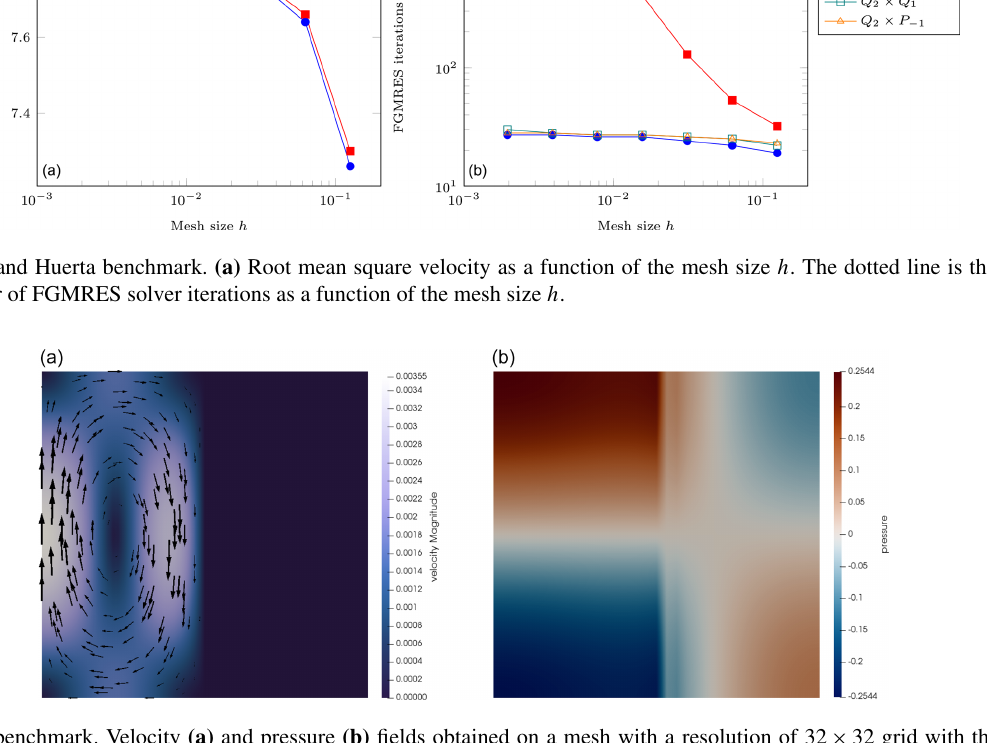
Figure 4. SolCx benchmark. Velocity (a) and pressure (b) fields obtained on a mesh with a resolution of 32 × 32 grid with the Q 2 × Q 1